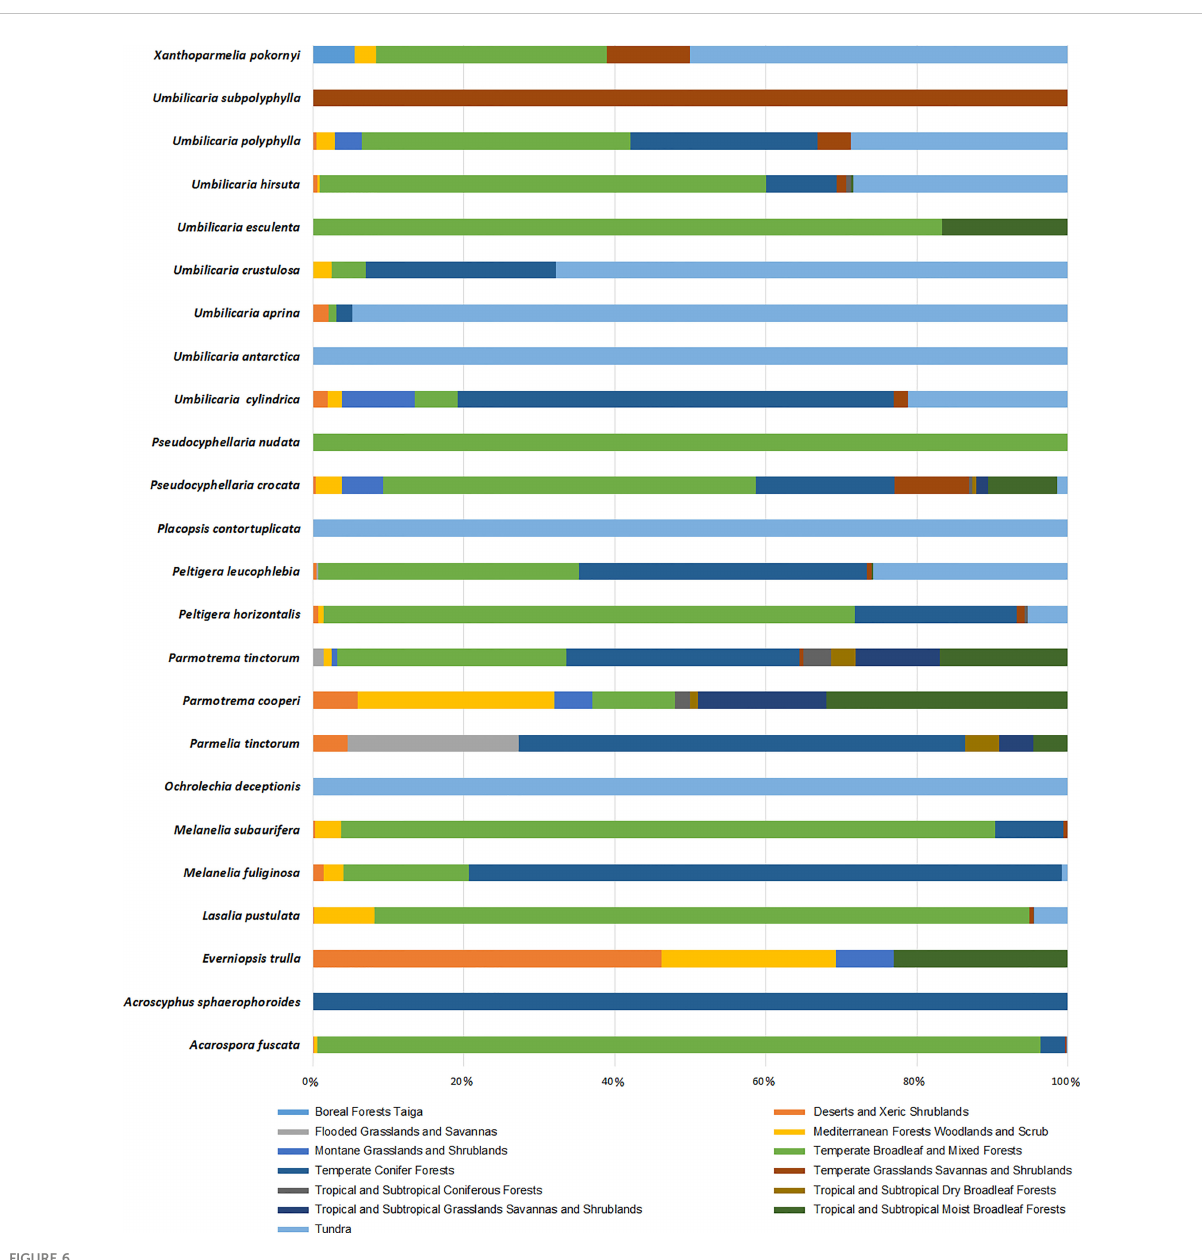
FIGURE 6 Biome-based occurrence of tridepside-containing lichen species; each bar represents the percentage of geographical occurrence of one lichen species in different biomes de fi ned by Olson et al. (2001); Updated scientiitalic> fi c names from Mycobank are shown here as updated name (= synonymy): Melanelixia fuliginosa (= Melanelia fuliginosa ); Melanelixia subaurifera (= Melanelia subaurifera ); Parmotrema tinctorum (= Parmelia tinctorum